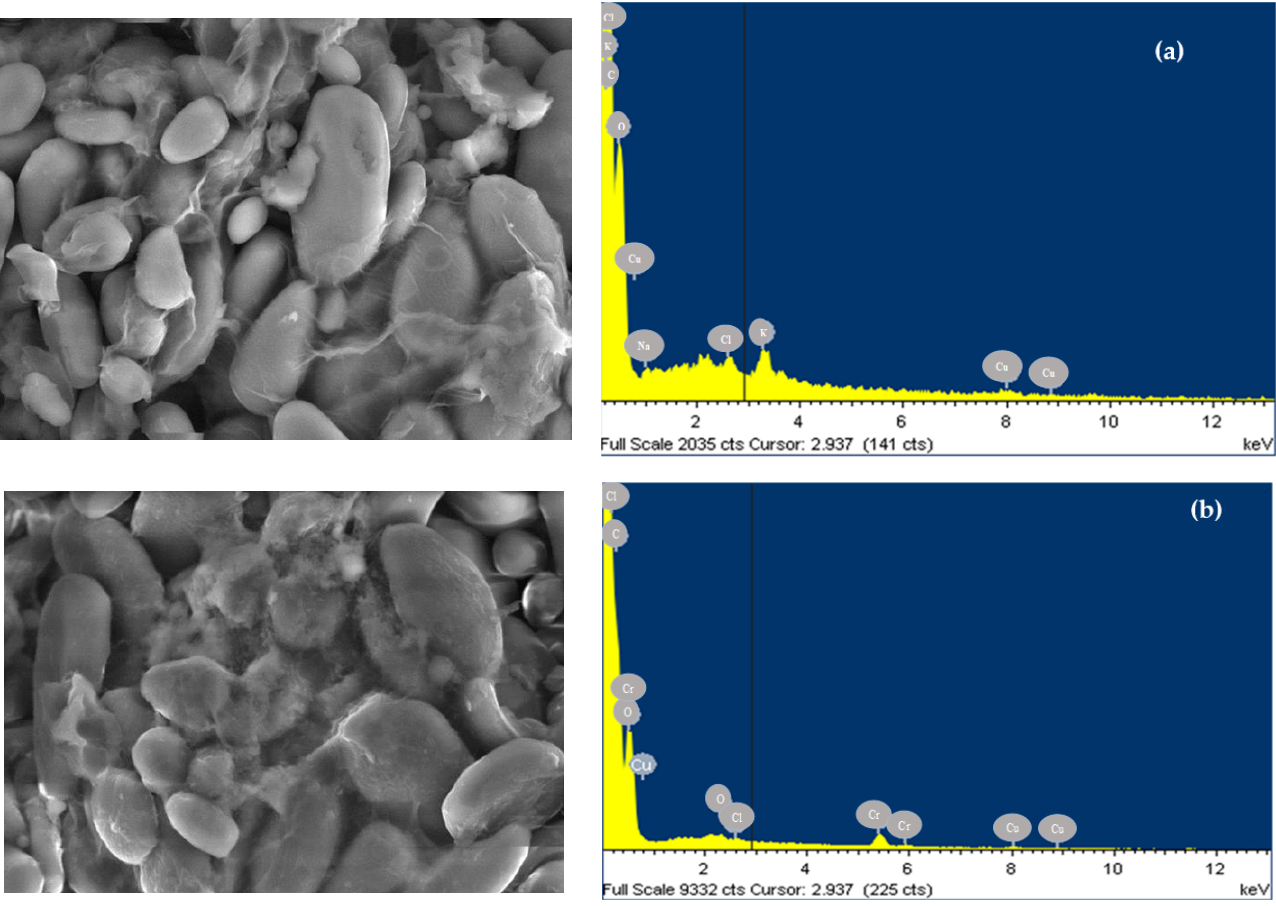
Figure 2. SEM micrographs amplified ×1000 and EDS spectrum of banana starch residues ( a ) before and ( b ) after Cr (VI) adsorption.